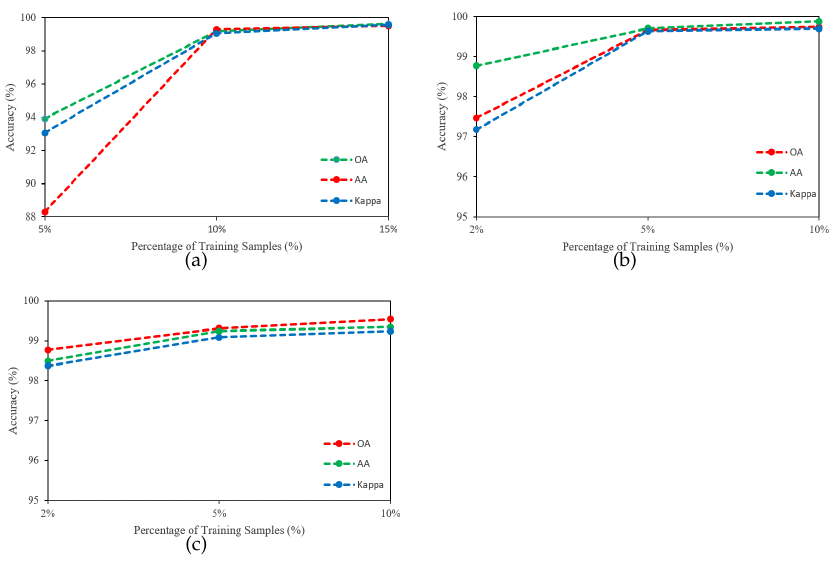
Figure 9. Accuracy (%) of SSCRN with different training percentages on three datasets: ( a ) IP, ( b ) SA, ( c ) PU.